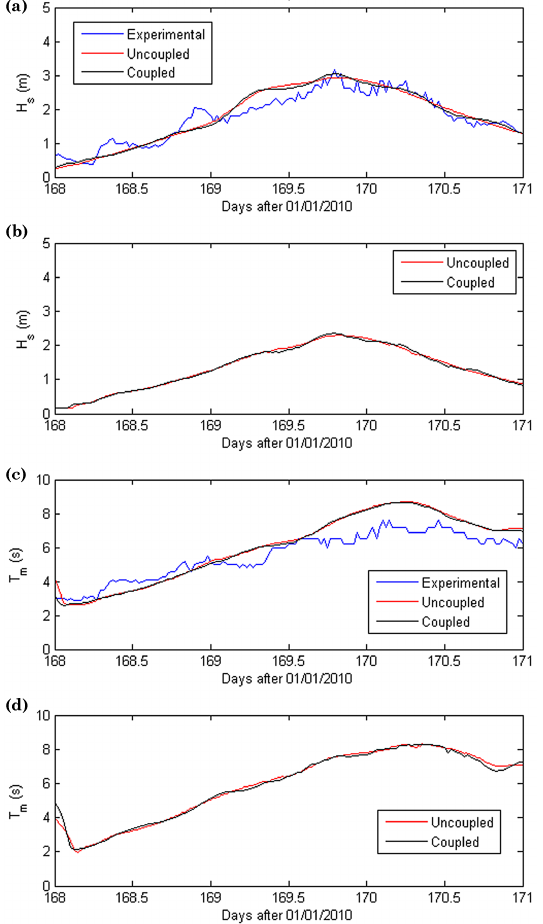
Figure 17. Wave conditions during the 19 June 2010 storm: (a) comparison between coupled and uncoupled modelled H s (m) with observed data in Firth of Forth wave gauge; (b) comparison between coupled and uncoupled modelled H s (m) in the Aberdeen wave gauge, no observed data were available from this wave gauge during this storm; (c) comparison between coupled and uncoupled modelled T m (s) with observed data in Firth of Forth wave gauge; (d) comparison between coupled and uncoupled modelled T m (s) in the Aberdeen wave gauge, no observed data were available from this wave gauge during this storm.